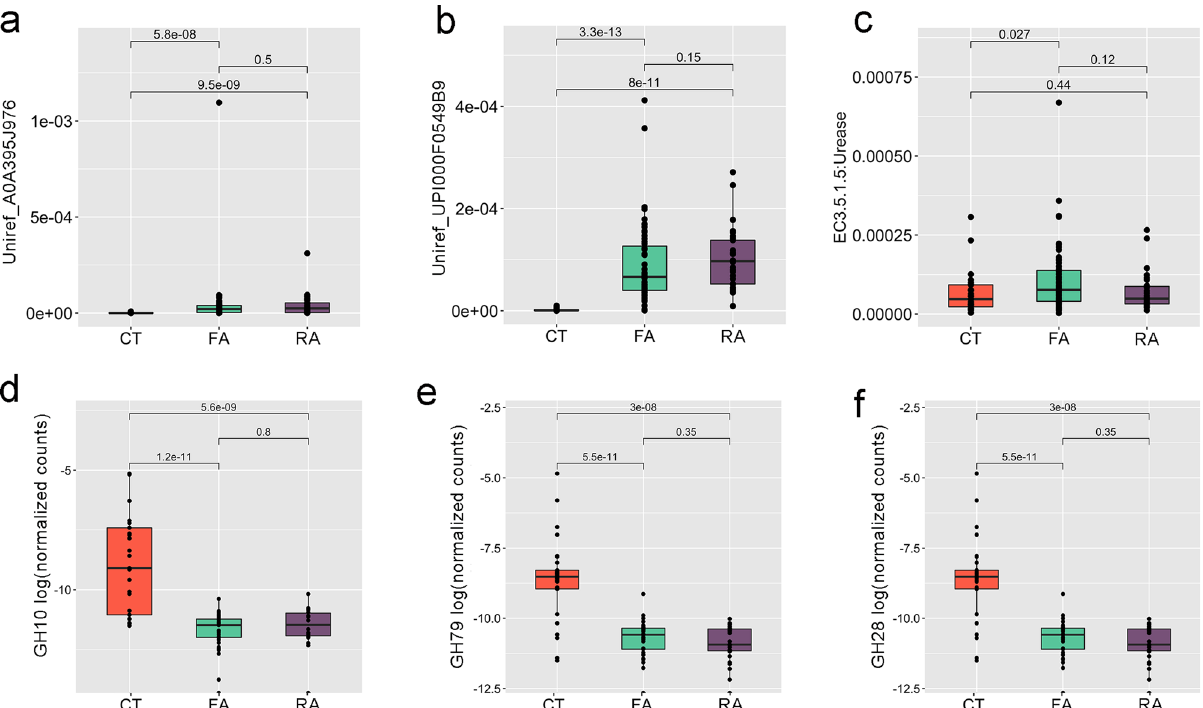
Fig. 4 Gut microbiome of allergic children shows a higher in fl ammatory potential and a reduced ability to degrade complex polysaccharides. Box plots showing the relative abundance of microbial genes involved in lipopolysaccharide biosynthesis ( a , b ), urea ( c ) and fi ber degradation ( d – f ) in healthy (CT), food (FA) and respiratory (RA) allergic children. Data of ( a – c ) are reported as relative abundance (number of reads/total number of reads per sample) from HUMAnN3 analysis; data of ( d – f ) are reported as normalized counts [log 10 (number of CAZy hits/total number of genes per sample)]. UniRef_ A0A395J976: O-antigen/teichoic acid export membrane protein; UniRef_UPI000F05499B: LPS biosynthesis protein. Boxes represent the interquartile range (IQR) between the fi rst and third quartiles, and the line inside represents the median (2nd quartile). Whiskers denote the lowest and the highest values within 1.5 x IQR from the fi rst and third quartiles, respectively. The signi fi cance was tested by applying pairwise Wilcoxon test. Data are obtained from n = 29, 55, and 30 biologically independent samples for CT, FA and RA,